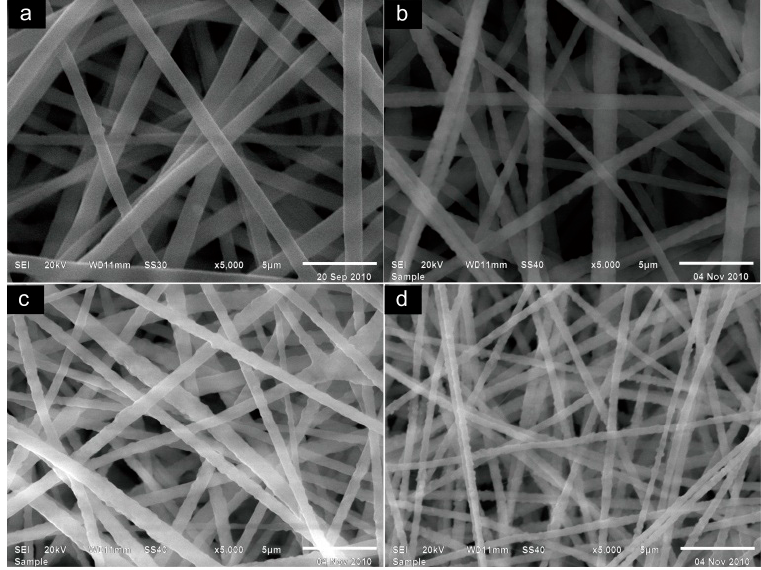
Figure 1. The scanning electronic microscopy (SEM) images of the membranes with nano-sized MgO: ( a ) 0 wt %; ( b ) 1 wt %; ( c ) 3 wt %; and ( d ) 7 wt %.